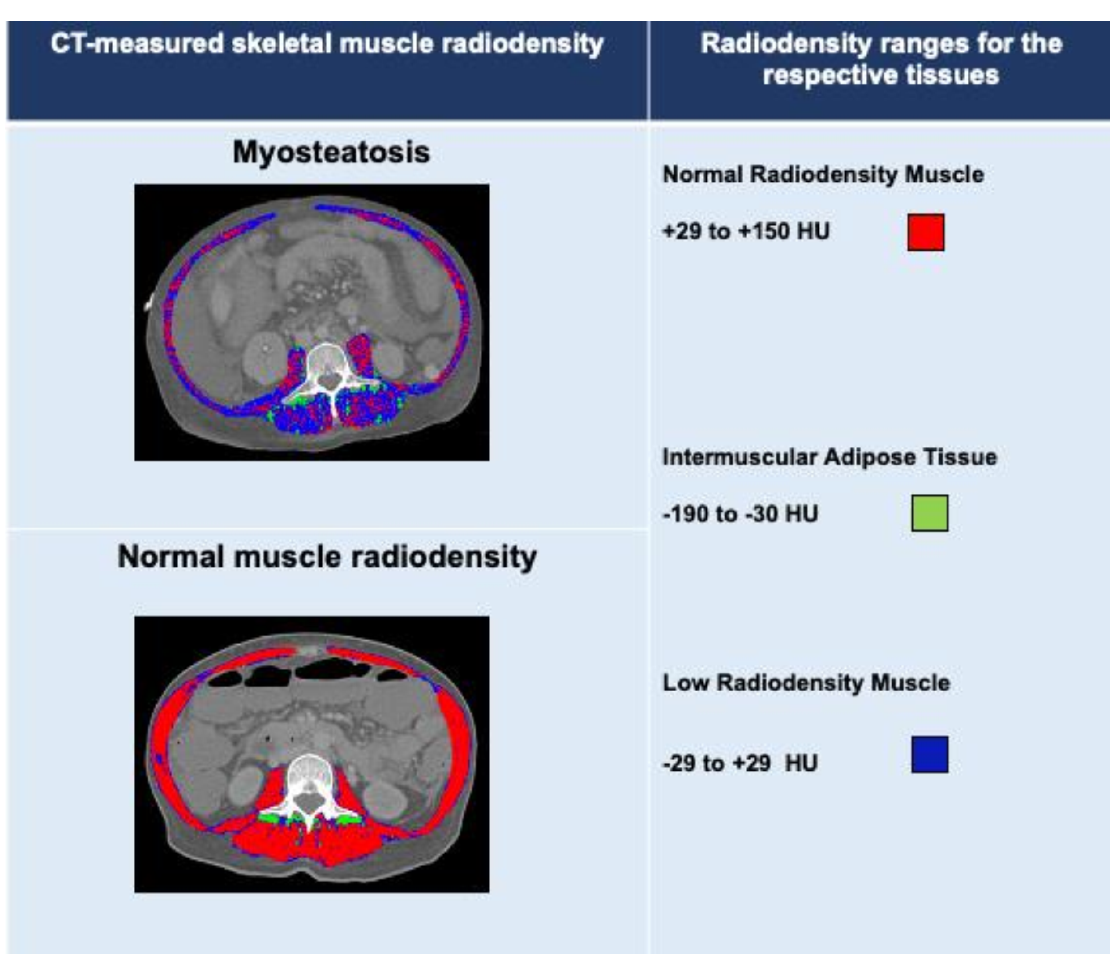
Figure 2. Abdominal computed tomography images taken at the third lumbar vertebra to quantify IMAT and muscle radiodensity in two patients with